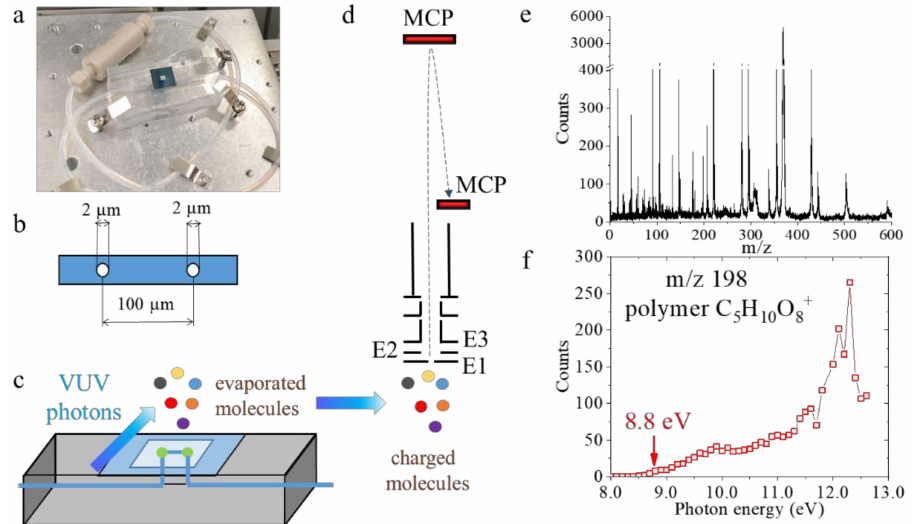
Figure 1. ( a ) A photograph of the System for Analysis at the Liquid Vacuum Interface (SALVI) device; ( b ) a schematic showing the two 2 µ m diameter apertures allowing evaporation of molecules on the SiN membrane covering the microchannel; ( c ) the relative position of the vacuum ultraviolet (VUV) photon beam from the SALVI device; ( d ) extraction and detection of charged molecules by the reflectron time-of-flight mass spectrometer; ( e ) a representative mass spectrum from the 2 h dark aging experiment acquired at 12.0 eV; and ( f ) a photoionization efficiency (PIE) curve of m / z 198 (C 5 H 10 O 8+ ) from the 2 h dark